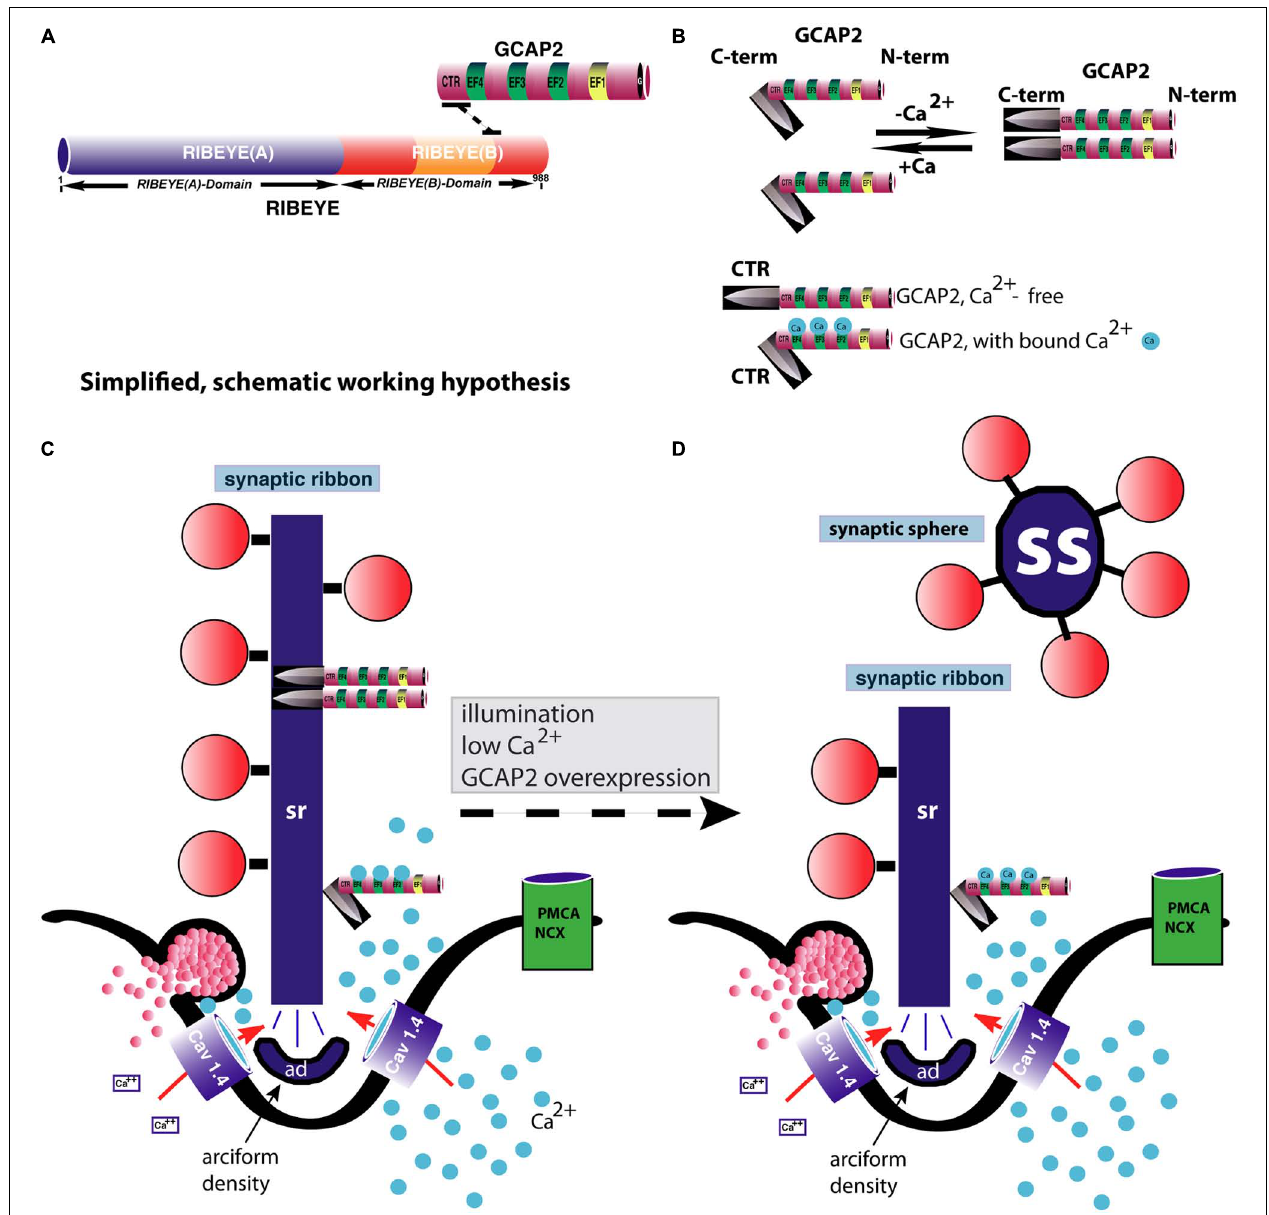
are getting shorter. Spherical ribbons, synaptic spheres, dissociate from the free cytosolic end of the synaptic ribbon.While NAD(H) favors binding of GCAP2 to RIBEYE, it weakens RIBEYE–RIBEYE interactions which might ease disassembly of the synaptic ribbon (Magupalli etal., 2008). For sake of clarity, intracellular membrane system, e.g., ER, and mitochondria which could influence intracellular Ca 2 + -levels were omitted in the schematic drawing.These compartments can be expected to further shape the Ca 2 + -signal in the presynaptic terminal. PMCA and NCX-proteins are schematically depicted.The C-terminus (CTR) of GCAP2 that interacts with RIBEYE and which is exposed particularly in the Ca 2 + -free form of GCAP2 is schematically depicted as a knife-like structure because it is proposed to severe the synaptic ribbon structure.The spheres colored in blue in (B–D) represent Ca 2 + -ions. sr, synaptic ribbon; ss, synaptic sphere; CTR, C-terminal region of GCAP2; PMCA, plasma membrane Ca 2 + -ATPases; NCX, Na + /Ca 2 + -exchanger; ad, arciform density (i.e., the presynaptic density of photoreceptor ribbon synapses); EF,